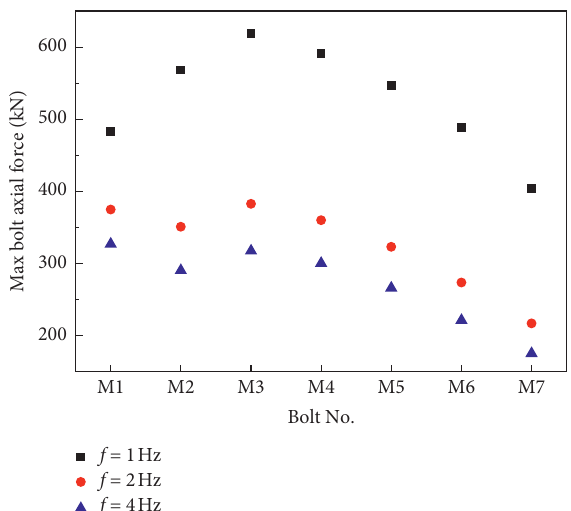
Figure 11: Maximum axial force of bolts at different